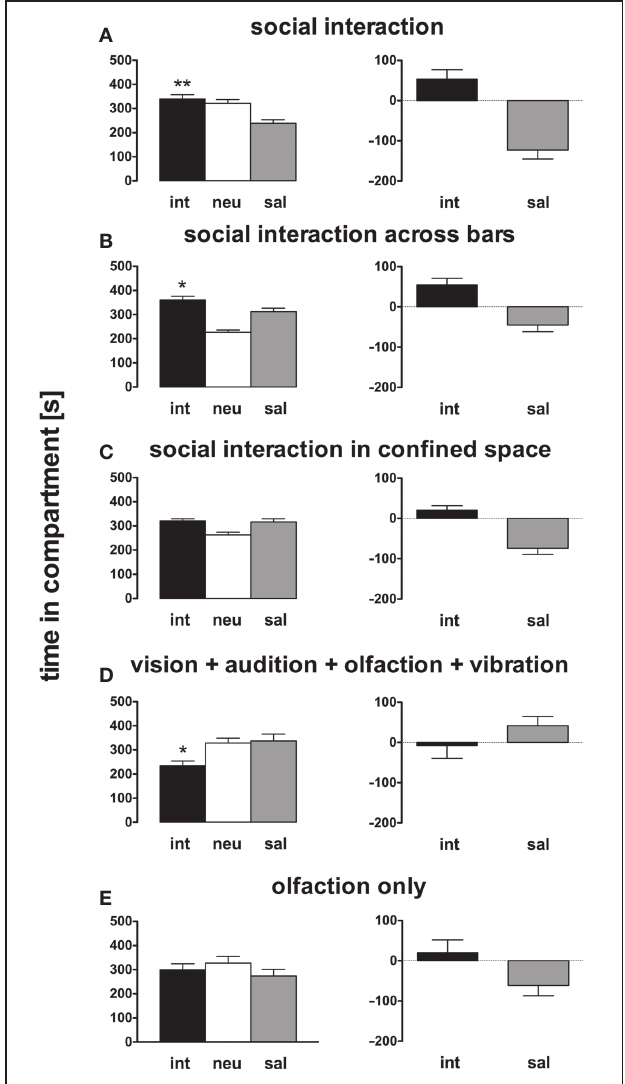
FIGURE 1 | CPP reward strength mediated by the various sensory modalities of the composite stimulus “social interaction.” Left column: times spent in the CPP apparatus compartments. Shown are group means ± SEM. int, saline & social interaction-paired compartment; neu, neutral compartment; sal, saline-paired compartment. ∗∗ p < 0 . 001 or ∗ p < 0 . 05 for time spent in int vs. sal (Tukey’s range test). Right column: preference scores (seconds spent in compartment during CPP test—seconds spent during pretest).